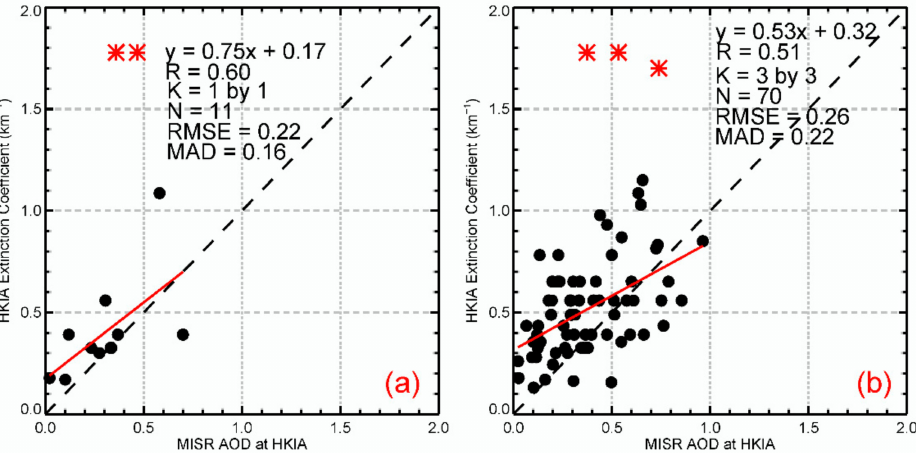
Figure 6. Correlation of Extinction Coefficient at HKIA with MISR AOD (17 km product at 558 nm) for kernel windows of ( a ) 1 by 1 and ( b ) 3 by 3. *—potential outlier in the data. Lines as described in Figure 2.